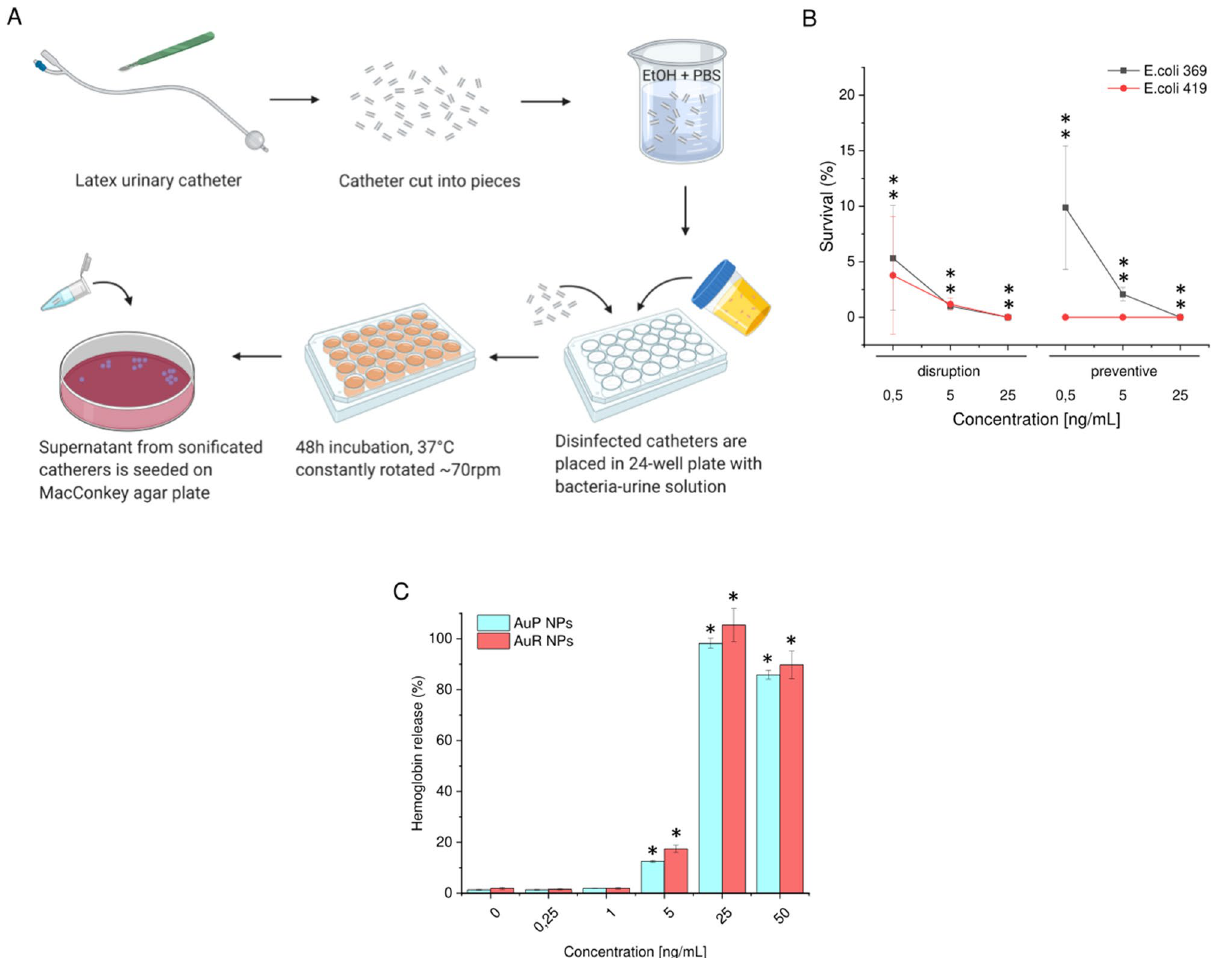
Figure 5. Overview of the urinary catheters-test experiment ( A ). Prevention of E. coli attachment and viability on latex urinary catheters incubated in the presence of bacteria-inoculated urine for 48 h ( B ). The release of hemoglobin from damaged RBCs upon treatment with AuP NPs and AuR NPs was investigated using a hemolysis assay ( C ). *Indicates statistical significance ( p < 0.05) when compared to erythrocytes incubated in the presence of PBS. Figure presented in ( A ) was created with